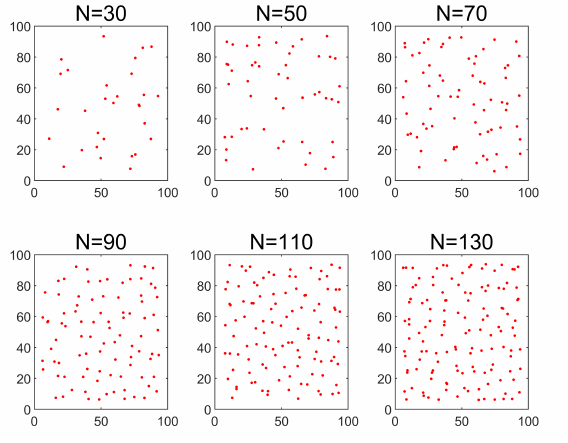
Figure 3. Different network